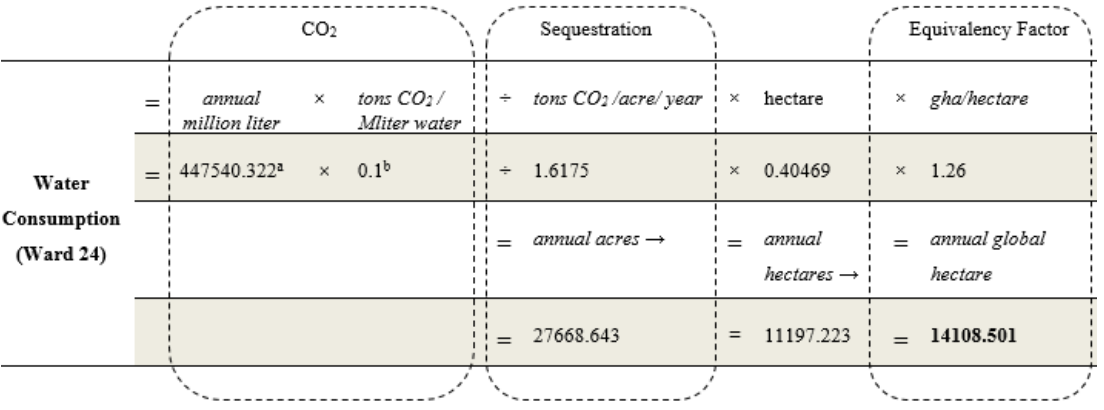
Figure 7. Water consumption footprint calculation and derivation. Source: a Household Survey of Ward 24 Residential Area (RA) (2015); Khulna Water Supply and Sewerage Authority (WASA) (2015); b [58].